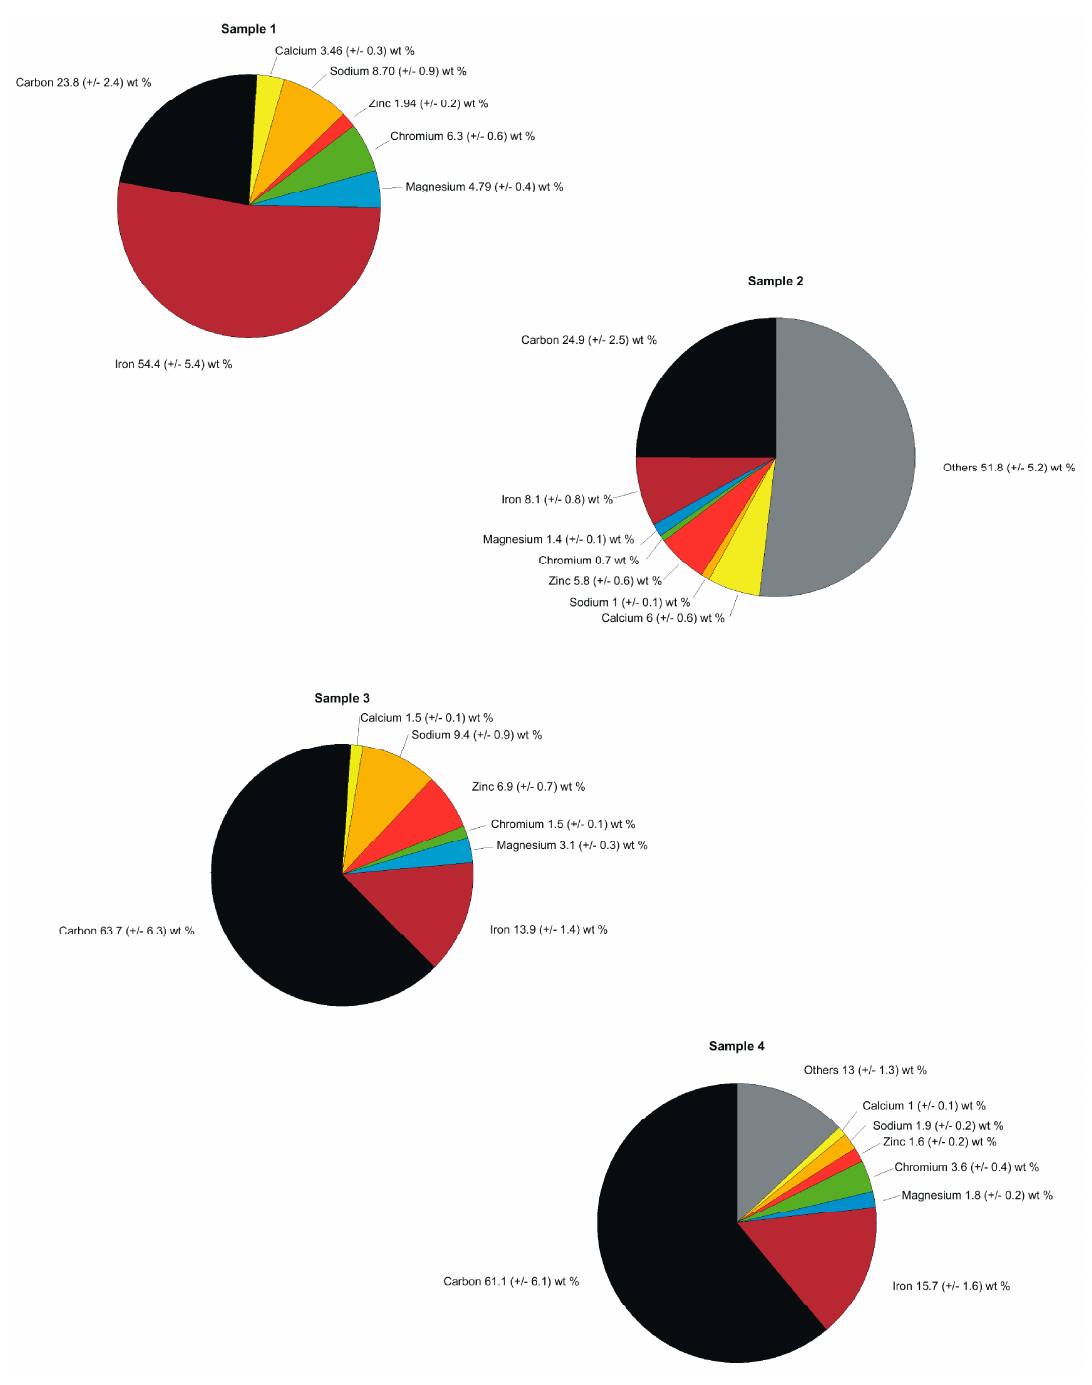
Figure 6. Quantitative determination of selected major chemical elements measured by LIBS, showing average values of wt% in different DPM matrices, (Sample 1, 2, 3 and 4) obtained from in-use passenger diesel combustion engine vehicles.